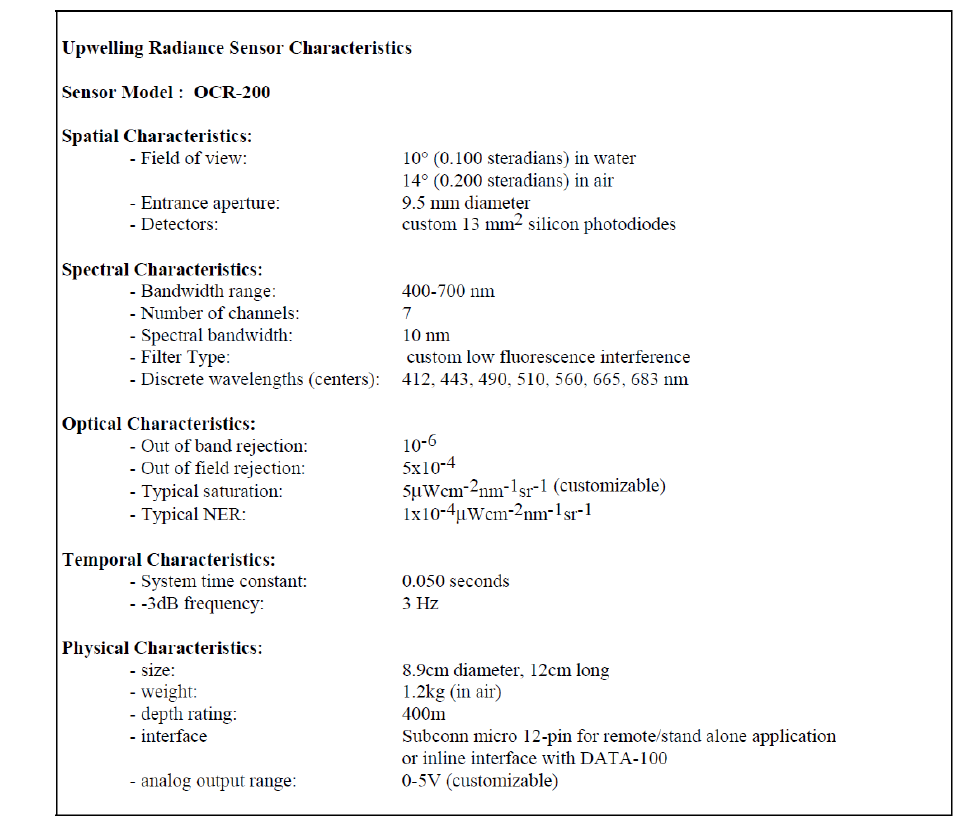
Figure 2. General specifications of the Satlantic ocean colour radiometers (OCR-200).